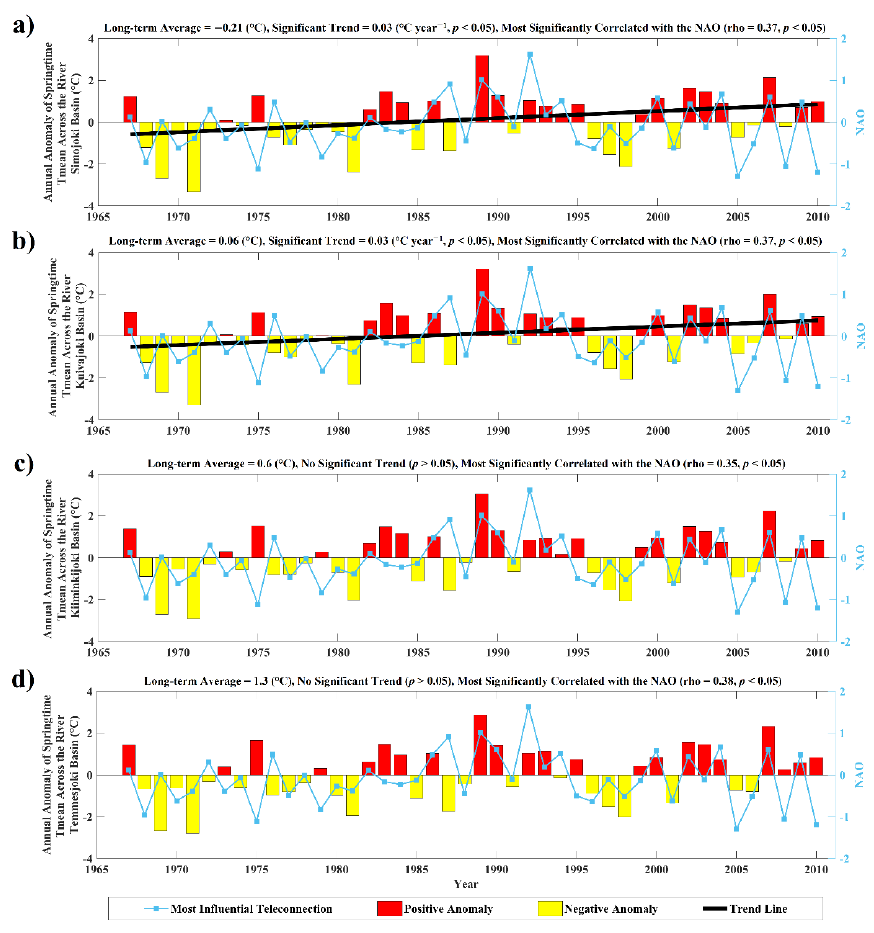
Figure 6. Annual anomalies with significant trend line ( p < 0.05) and the most influential springtime climate teleconnection for springtime Tmean in the ( a ) Simojoki, ( b ) Kuivajoki, ( c ) Kiiminkijoki, and ( d ) Temmesjoki rivers basins across northern Finland during 1967 – 2011.